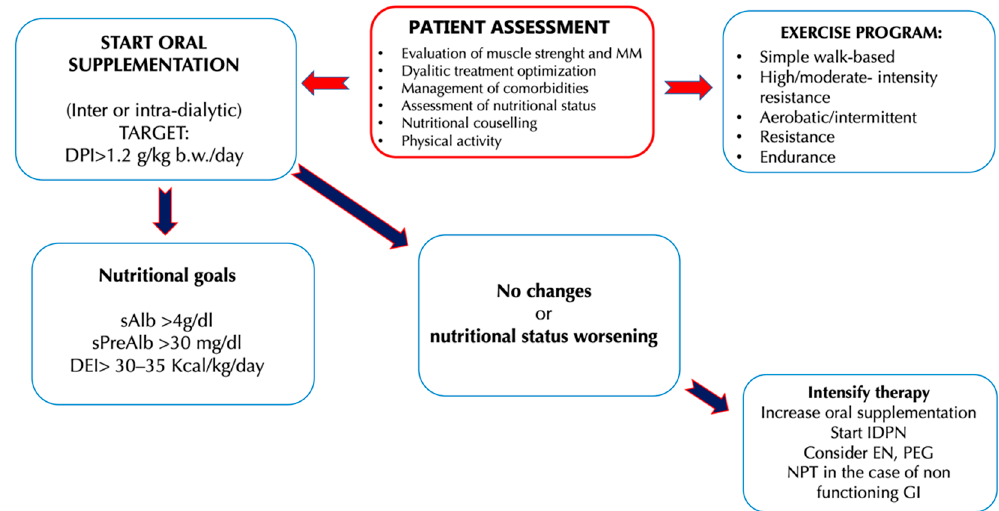
Figure 2. Clinical management of hemodialysis (HD) patients to counteract the onset and the progression of uremic sarcopenia [91]. Abbreviations: b.w., Body weight; DEI, Diet energy intake; DPI, Diet protein intake; EN, Enteral nutritional; GI, Gastrointestinal; IDPN, Intra-parenteral nutrition dialysis; MIS, Malnutrition inflammation score; MM, Muscle mass; PEG, Percutaneous endoscopic gastrectomy; SGA, Subject global assessment; TPN, Total parenteral nutrition.